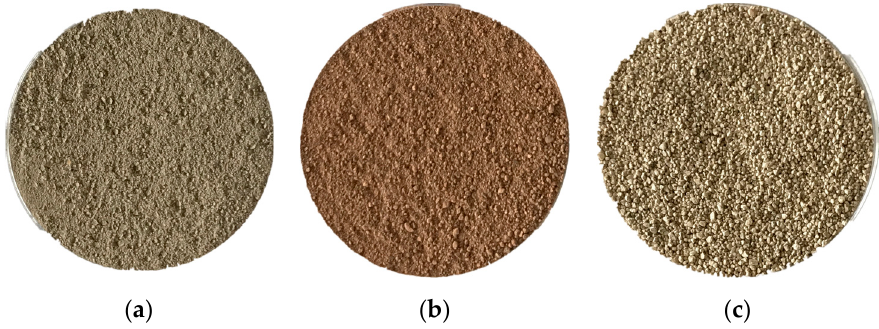
Figure 3. RGB images of paddy soil ( a ), red soil ( b ) and seashore saline soil ( c ) samples.